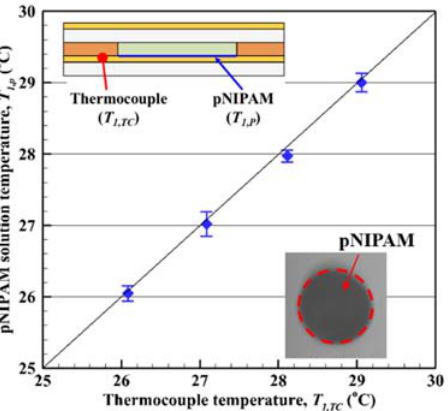
Figure 4. Comparison of temperature between pNIPAM solution measurement, T 1,p , and thermocouple, T 1,TC .